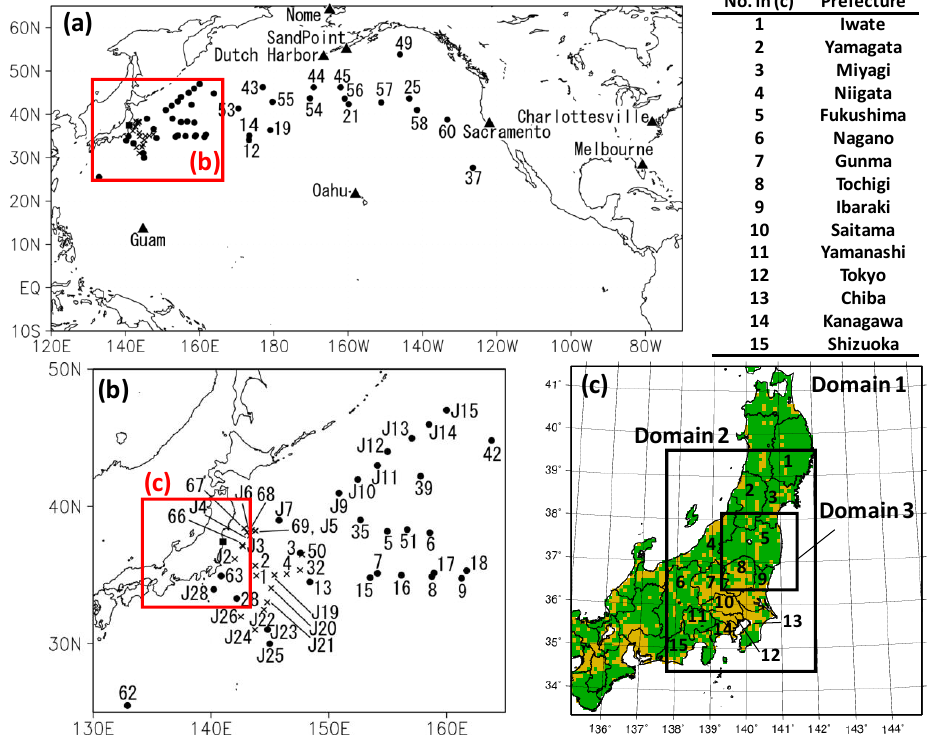
Figure 3. The simulation domains for (a, b) the oceanic dispersion and (c) the atmospheric dispersion simulations. The sampling locations of the sea surface concentration data for the source term estimation are plotted in (a) and (b) (black circles), while the sampling points affected by the direct release of radionuclides from the FNPS1 to the ocean were not considered in the reverse estimation (crosses), as indicated by Kobayashi et al. (2013). The prefectures (number) and forest cover (green shaded areas) over eastern Japan are shown in (c)